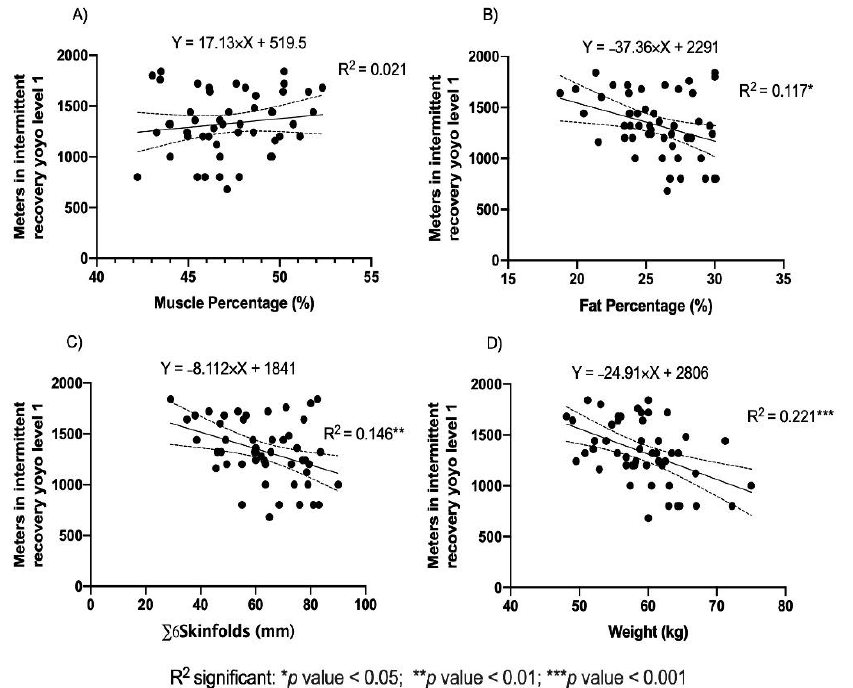
Figure 7. Simple linear regressions between yo-yo test and anthropometric variables ( A ): Muscle Percent; ( B ): Fat Percentage; ( C ): Σ 6Skinfolds and ( D ): Weight.